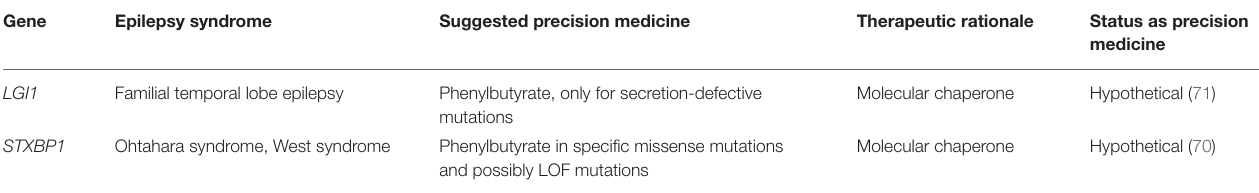
TABLE 5 | Molecular chaperone